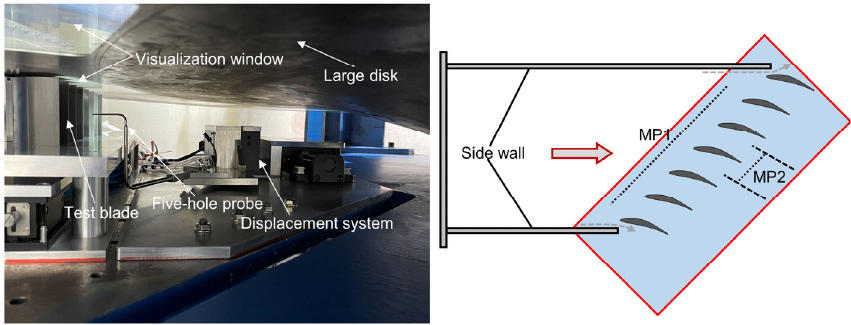
Figure 18. Details of the test section and instrumentation.